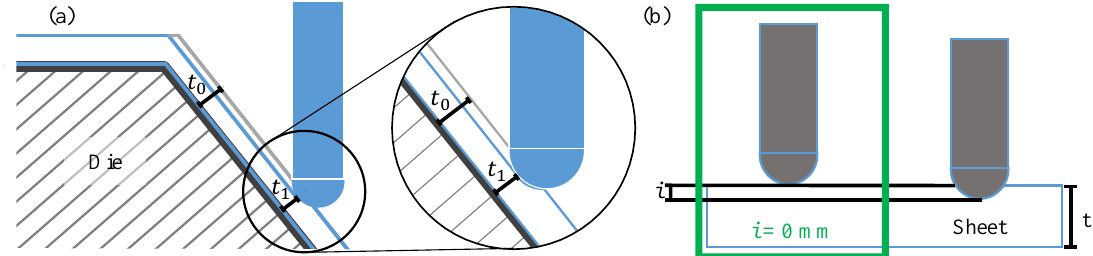
Figure 1. ( a ) TPIF assuming no thinning in tool path planning (grey) and considering thinning in tool path planning (blue); and ( b ) scheme for tool path without intrusion (left) and with intrusion (right) ( i , intrusion depth; t , sheet thickness).